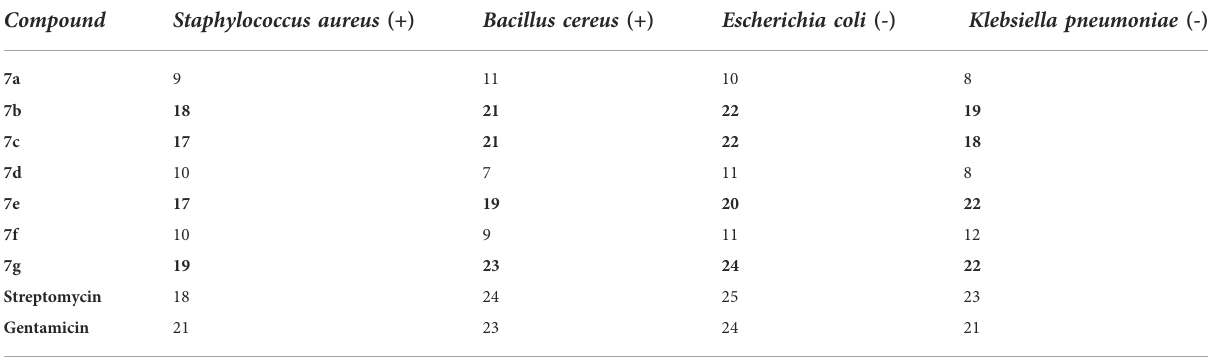
TABLE 4 Antibacterial activity of spiropyridoindolepyrrolidines 7a-7g.